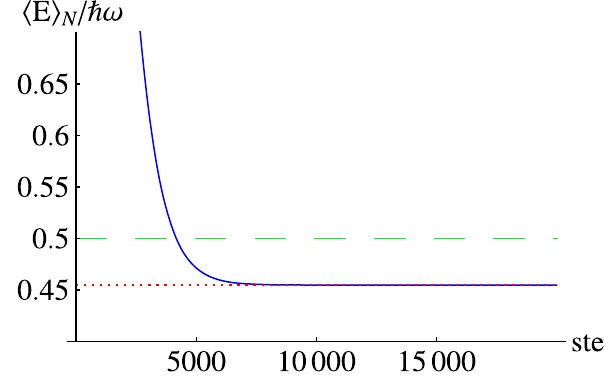
FIG. 4. Average energy (solid blue line) for the ensemble of worlds, as a function of iteration step. Details as in Fig. 3. Note that convergence to the exact value for MIW is ð 1 − 1 =N Þ ℏ ω = 2 (red dotted line), which coincides with the quantum mechanical value of ℏ ω = 2 (green dashed line) for N → ∞ .